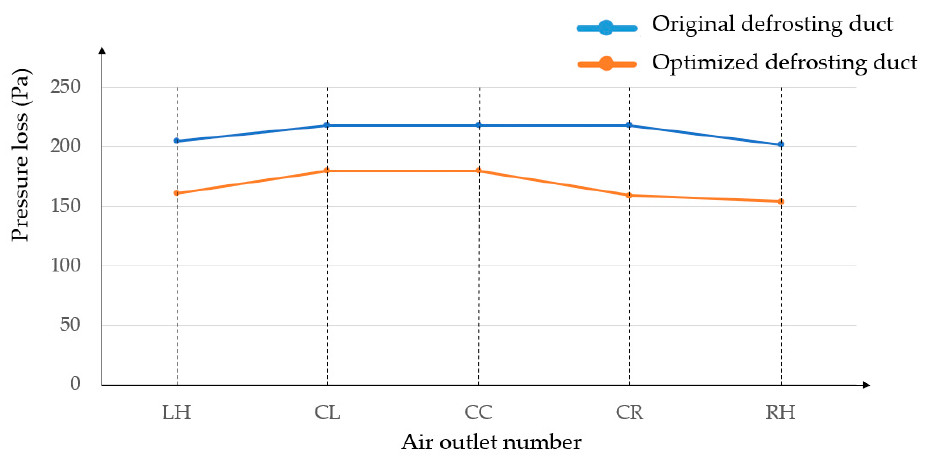
Figure 8. Comparison of pressure loss before and after optimization.